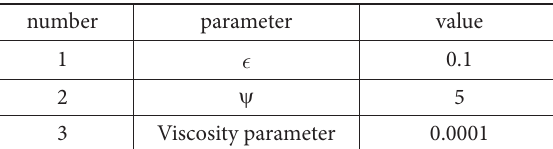
Fig. 8. The value of the objective function versus viscosity parameter in biaxial compression Table 1. Selected parameters which minimize the objective function in uniaxial and biaxial compression test